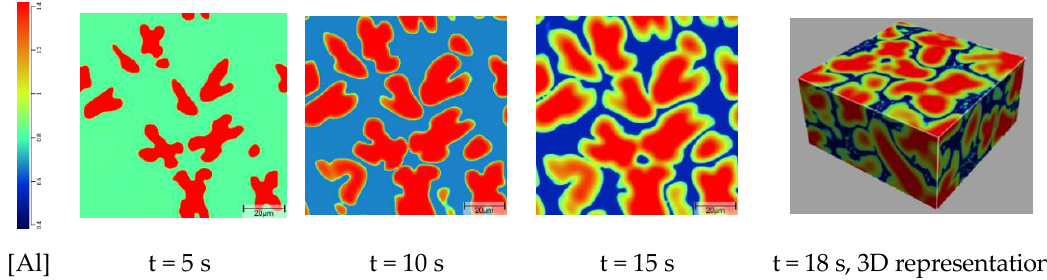
Figure 2. Microstructure evolution in Zn20Al0.7Cu during solidification represented by the Al concentration. Size of the 2D cutting plane in the middle of the 3D box: 100 µm × 100 µm.